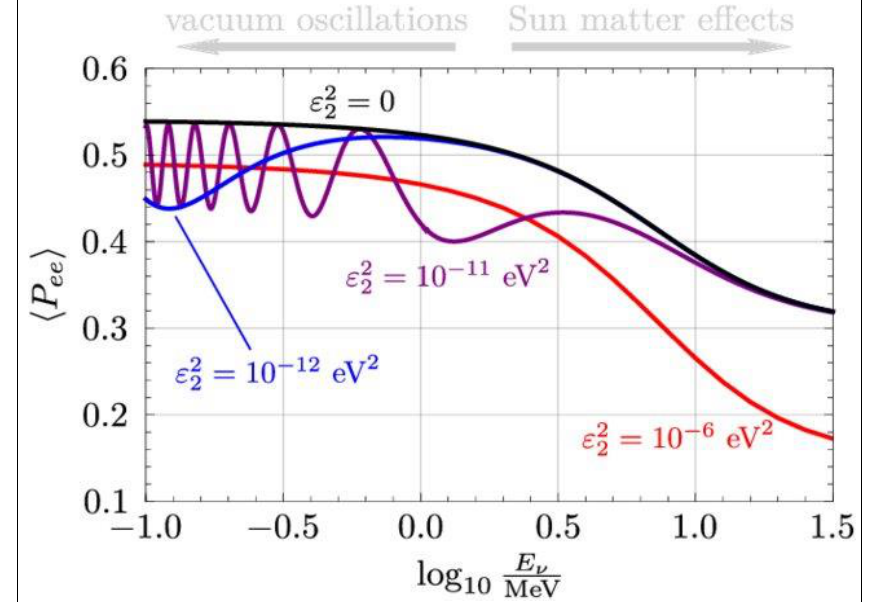
Figure 2. Electron Neutrino survival probability at Earth detection for neutrinos produced in a solar plasma with matter potential [38]